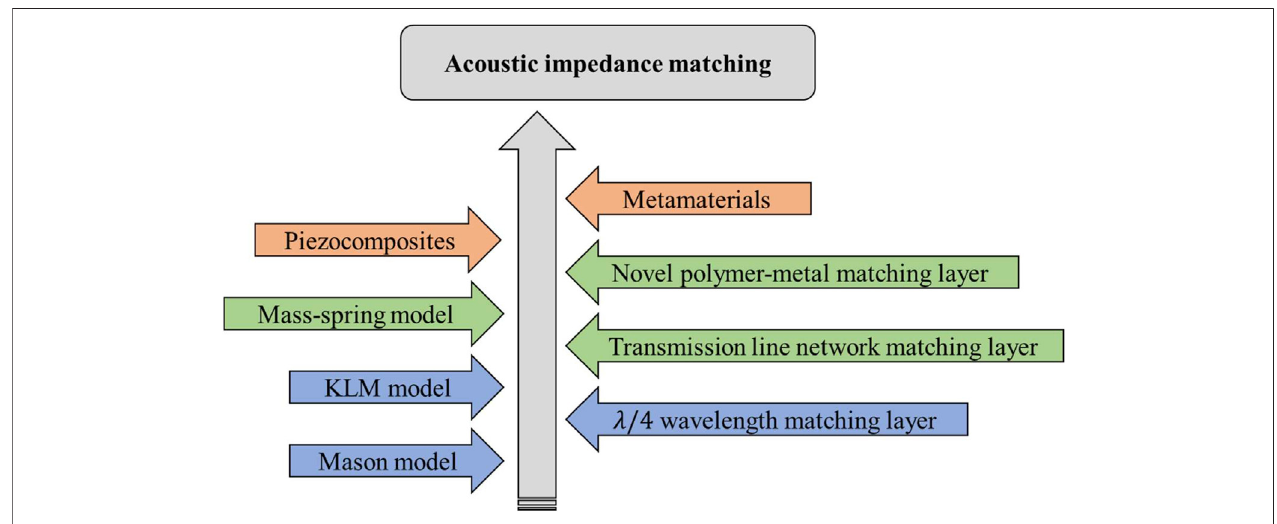
FIGURE 10 | Block diagram of Acoustic impedance matching (Rathod, 2020).